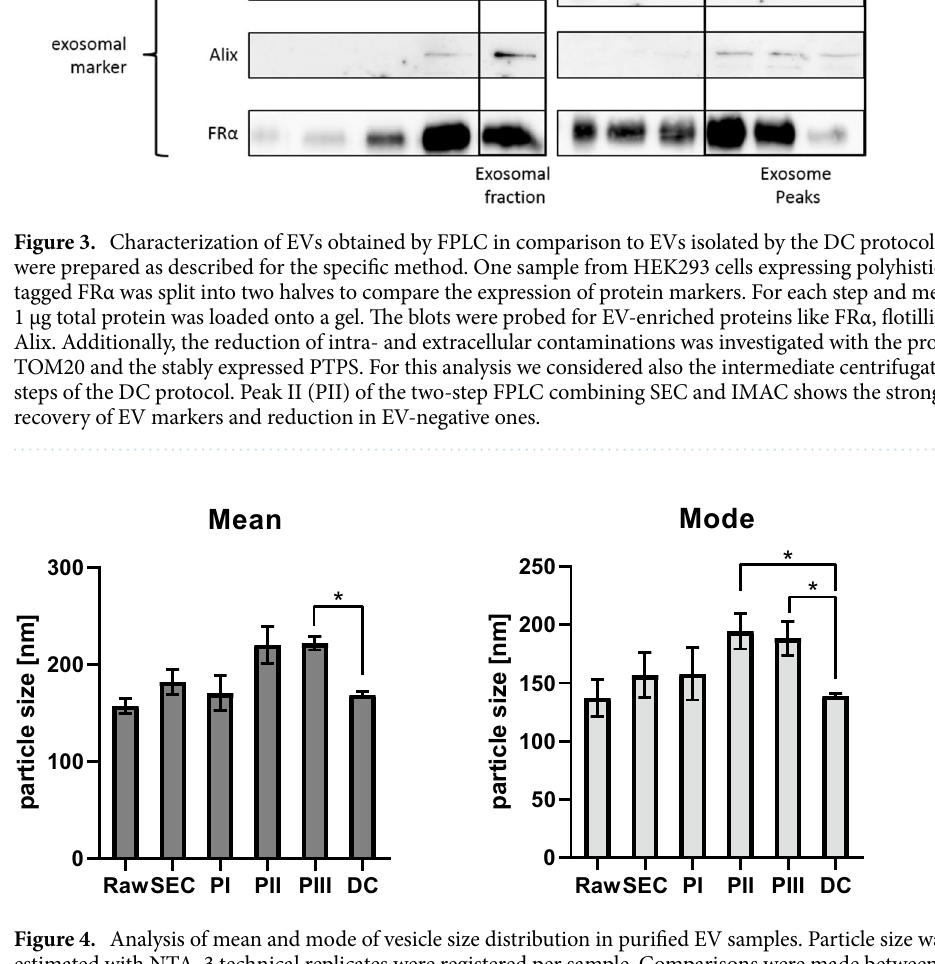
the raw sample, the SEC product or the second peak of the IMAC product were labeled with a primary anti-FRα antibody and then with a fluorescent secondary antibody. Total and fluorescent particle concentration of each sample, as well as the size distribution of both populations, was then estimated with NTA. In the bar graphs in Fig. 6A, the concentration of fluorescent particles is reported as a percentage of total particles in the sample. Fluorescent particles represented a significant percentage of the total particles within the raw sample. However, it is possible that part of these fluorescent signals originated from soluble FRα that was subsequently removed by SEC. The final FPLC product preferentially contained fluorescent particles (65% ± 20.12 s.d.) but a consider- able number of FRα-negative particles remained. Considering the size distribution of the FPLC product, most of these unlabelled contaminants are smaller than EVs (< 30 nm) and thus may represent protein aggregates or membrane fragments (Fig. 6B). The one-way ANOVA test on the data confirmed a significant ( p = 0.0421) difference between means. When comparing the final FPLC product with the previous purification stages, the difference with the raw sample was statistically significant (Sidak’s multiple comparisons test, p = 0.0425).